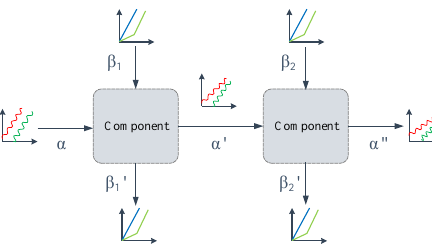
Figure 8. A model consisting of two